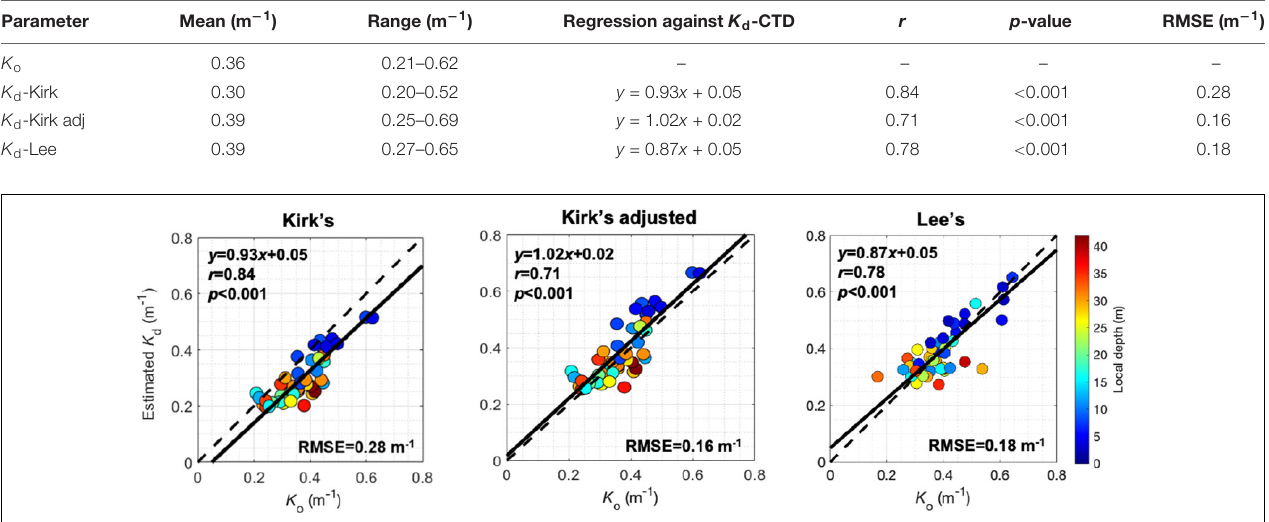
FIGURE 7 | Scatter plots between the reference ( K o ) and K d -Kirk ( Left ), and K d -Kirk adjusted ( Center ) and K d -Lee ( Right ) with local sampling depth as